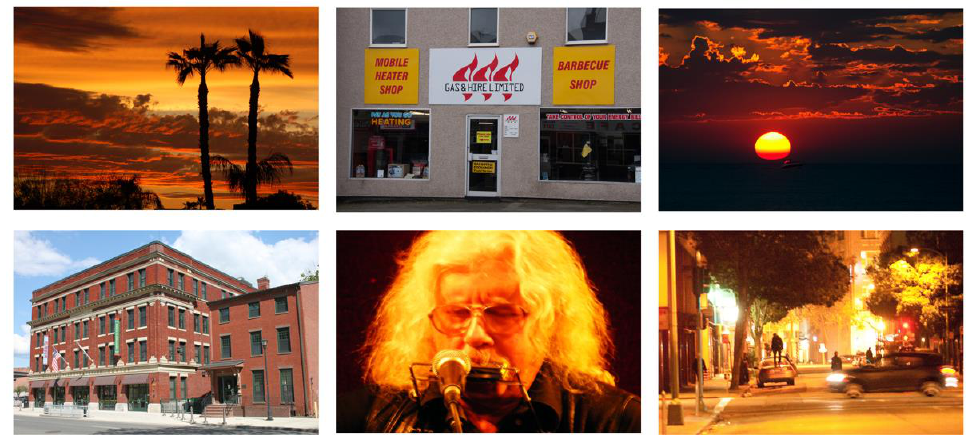
Figure 3. Part of the interference images.